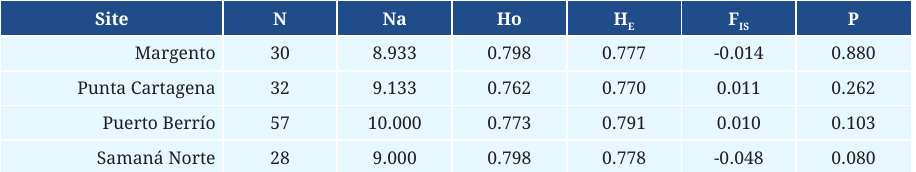
TABLE 2 | Genetic diversity of Pseudoplatystoma magdaleniatum from four sampling sites in the Magdalena-Cauca basin (Colombia) using 15 microsatellite loci. N: sample size; Na: average number of alleles per locus; H : observed heterozygosity; H : expected heterozygosity; F : inbreeding coefficient; O E IS P: p-value for Hardy-Weinberg equilibrium